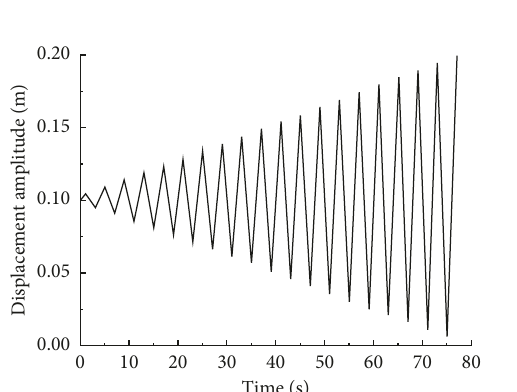
Figure 11: Horizontal displacement loading